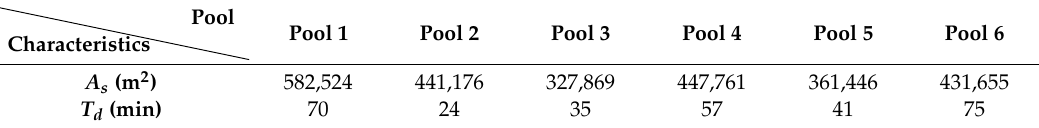
Table 2. Basic parameters and initial flow condition of each